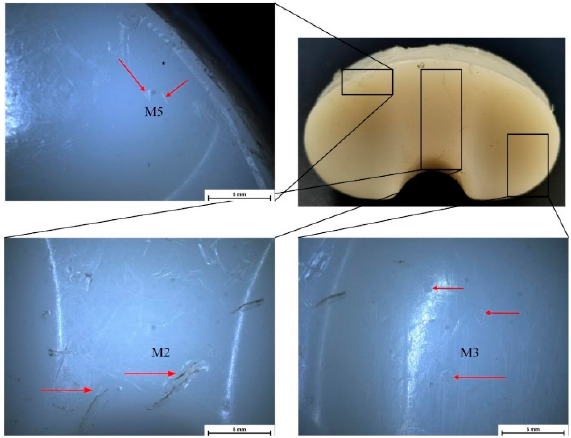
Figure 4. Stereomicroscopy images obtained in the case of IT1 sample.